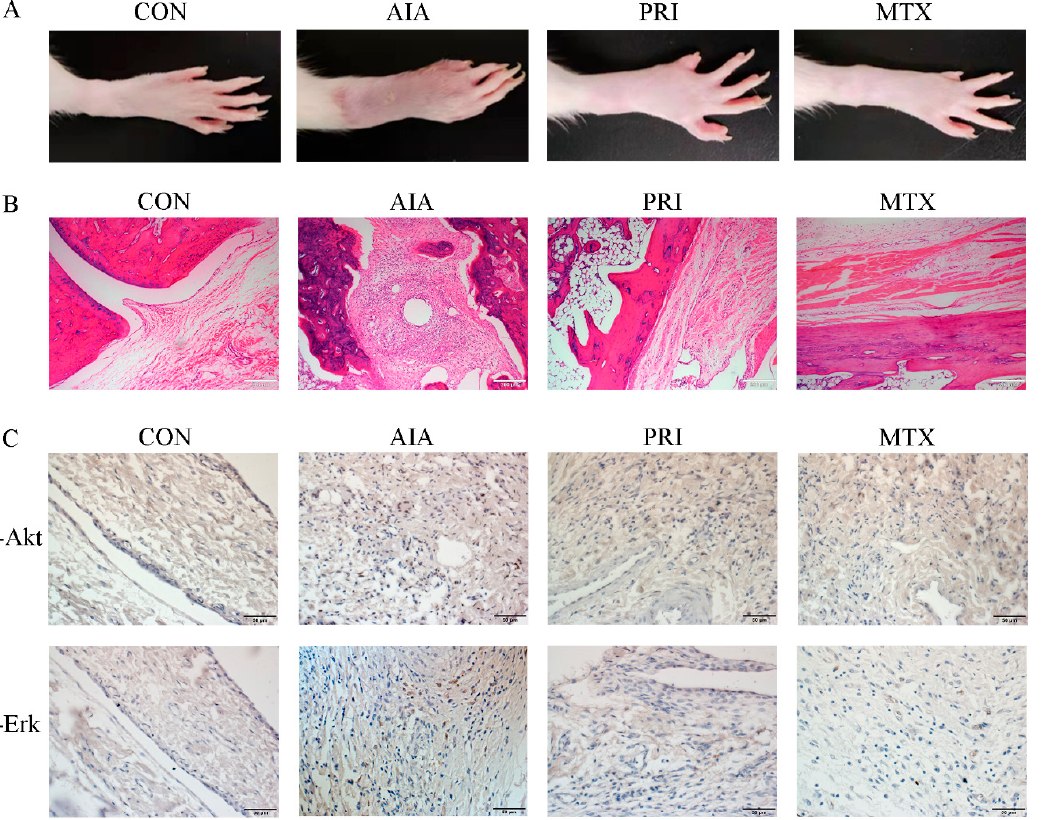
Figure 6. Typical photos of PRI effects on right hind paws of rats ( A ), histopathological changes in ankle joints ( B , ×100, HE staining) and the immunohistochemical expression of anti-p-Akt and anti- p-Erk antibodies in ankle joints ( C , ×400, D ), * p < 0.05 compared with AIA group, ### p < 0.001 compared with CON group. 4. Discussion RA is characterized by chronic inflammation of synovial tissue and progressive de- struction of cartilage and bone, which is defined as the most common autoimmune, de- structive, inflammatory arthritis in adults [26]. Without immediate and appropriate treat- ment, the pathological process of patients may lead to joint deformity and disability. Cur- rently, commonly used agents for the RA treatment include non-steroidal anti-inflamma- tory drugs (NSAIDs), disease modifying anti-rheumatic drugs (DMARDs), glucocorti- coids and biological agents [27,28]. However, some unanticipated adverse effects